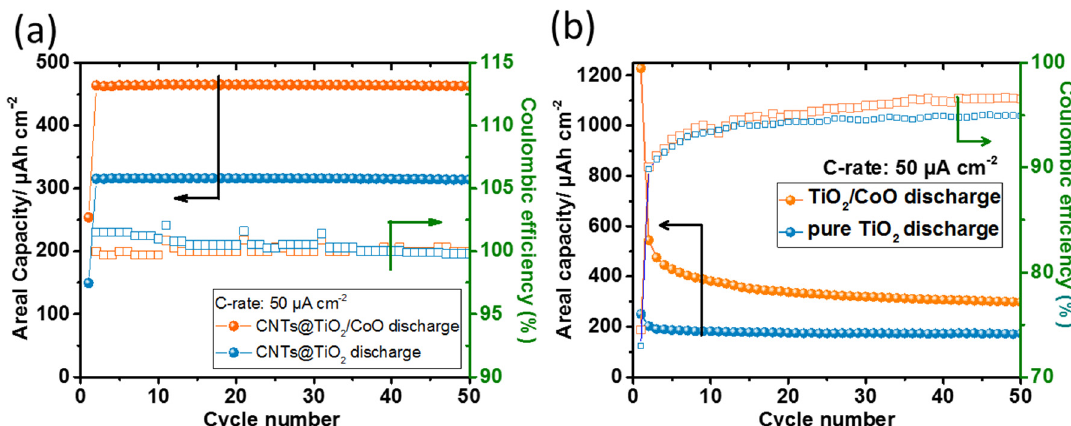
Figure 5. Galvanostatic areal discharging capacities as a function of cycle number, obtained at a current density of 50 µA·cm − 2 for CNTs@TiO 2 and CNTs@TiO 2 /CoO NT anodes and their corresponding Coulombic efficiencies (CE) ( a ); cycling performance of uncovered TiO 2 and TiO 2 /CoO NT electrodes with the corresponding CE ( b ).